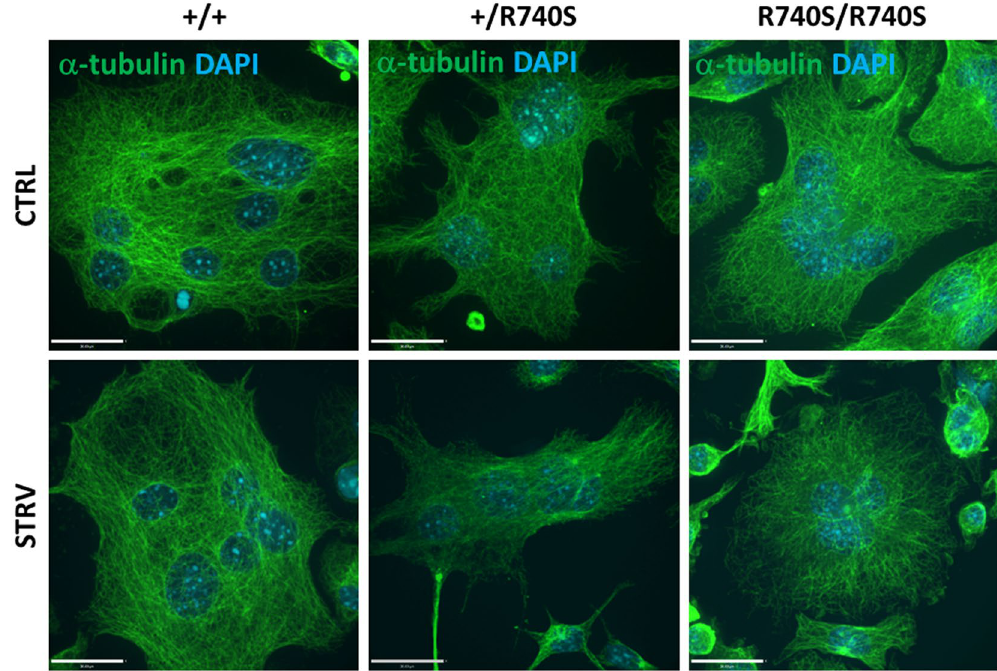
Figure 4. Microtubular organization in osteoclasts. Cells were cultured as described in “Materials and Methods” and stained using anti- α -tubulin antibody; nuclei were stained with DAPI. STRV = starvation, HBSS, 1 hr. Representative images of three independent experiments; bars 20 µ